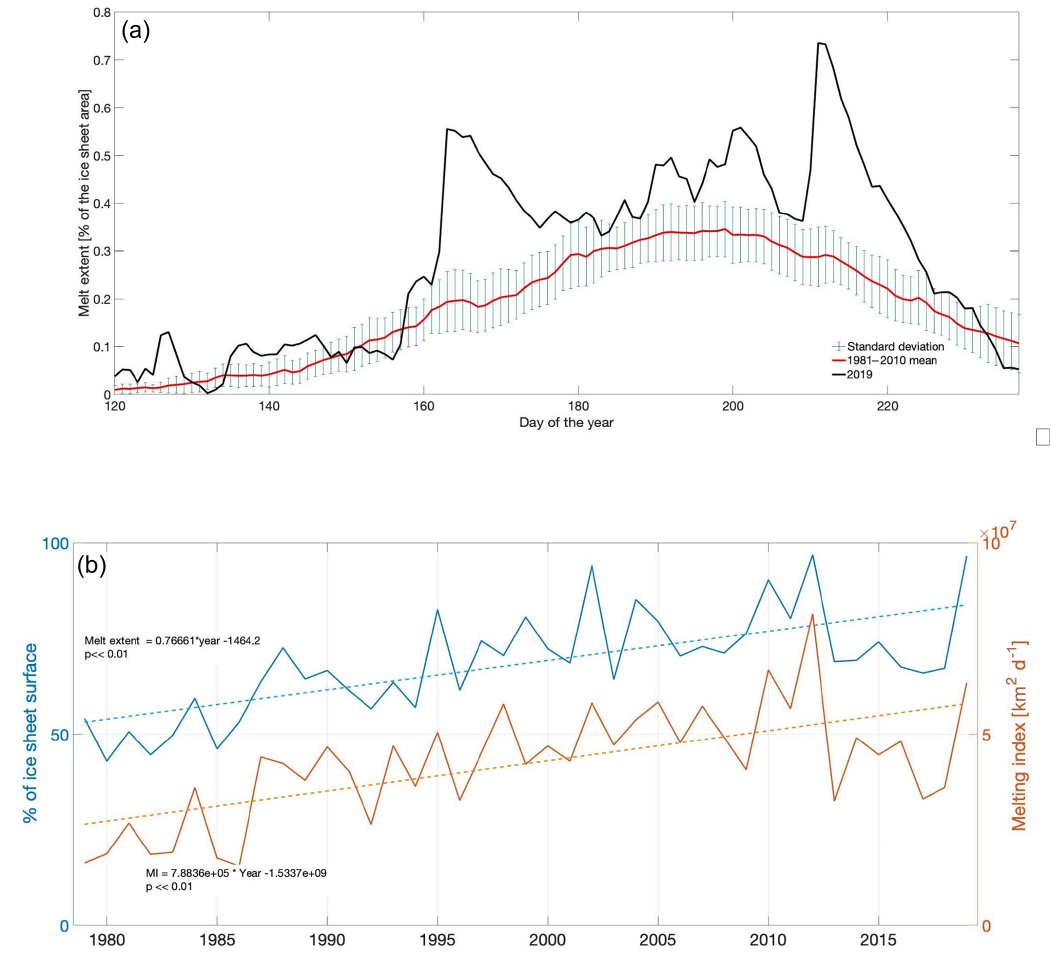
Figure 2. (a) Daily time series of melt extent (expressed as a percentage of the total ice sheet area) during 2019 (black line). The red line indicates the average values for the baseline period 1981–2010. Vertical gray bars indicate the standard deviation of melt extent for the 1981–2010 baseline period. (b) Summer maximum melt extent (as a percentage of the ice sheet surface, blue line, left axis) and melting index (e.g., number of melting days times the area undergoing melting, square kilometers per day, orange line, right axis) obtained from spaceborne passive microwave observations for the period